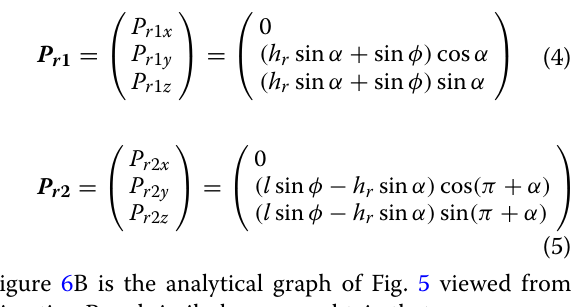
Figure 6B is the analytical graph of Fig. 5 viewed from direction B and similarly we can obtain that: